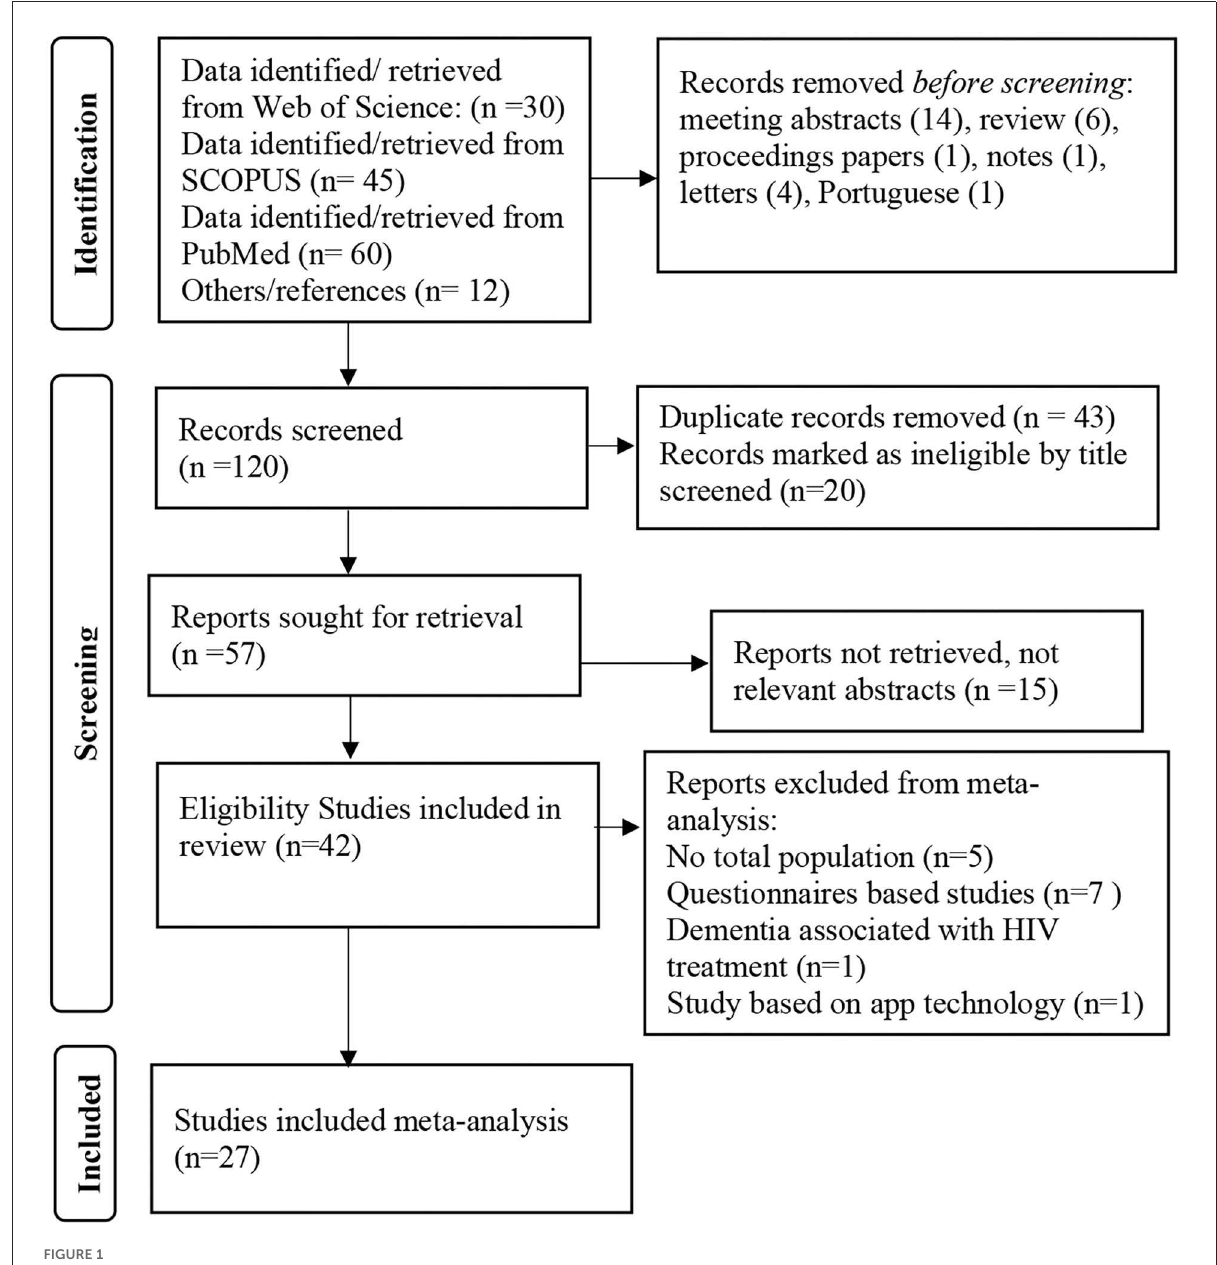
FIGURE1 Study selection